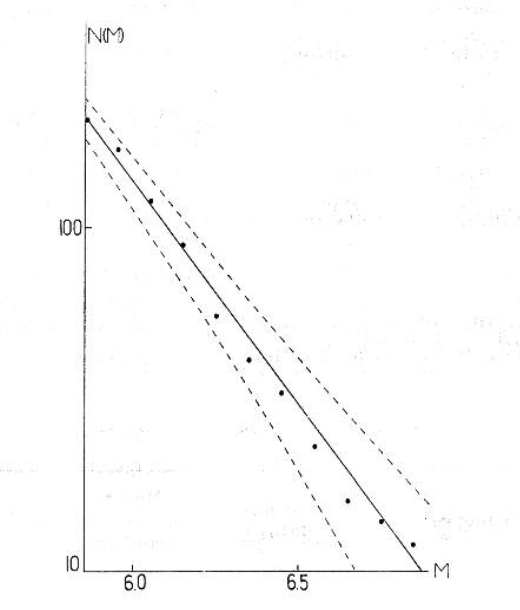
Figure 7. Magnitude-frequency distribution: Aleutian Islands 1957. Figure 8. Magnitude-frequency distribution: Kern County